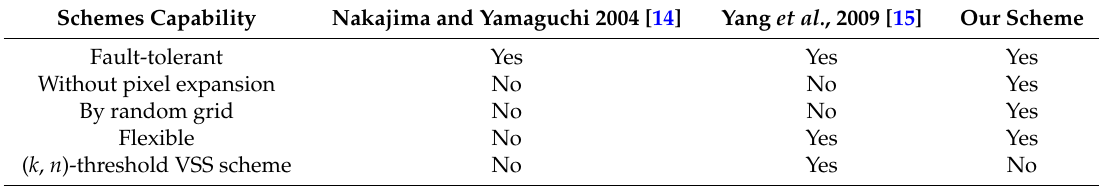
Table 10. Comparison of our scheme with the previous